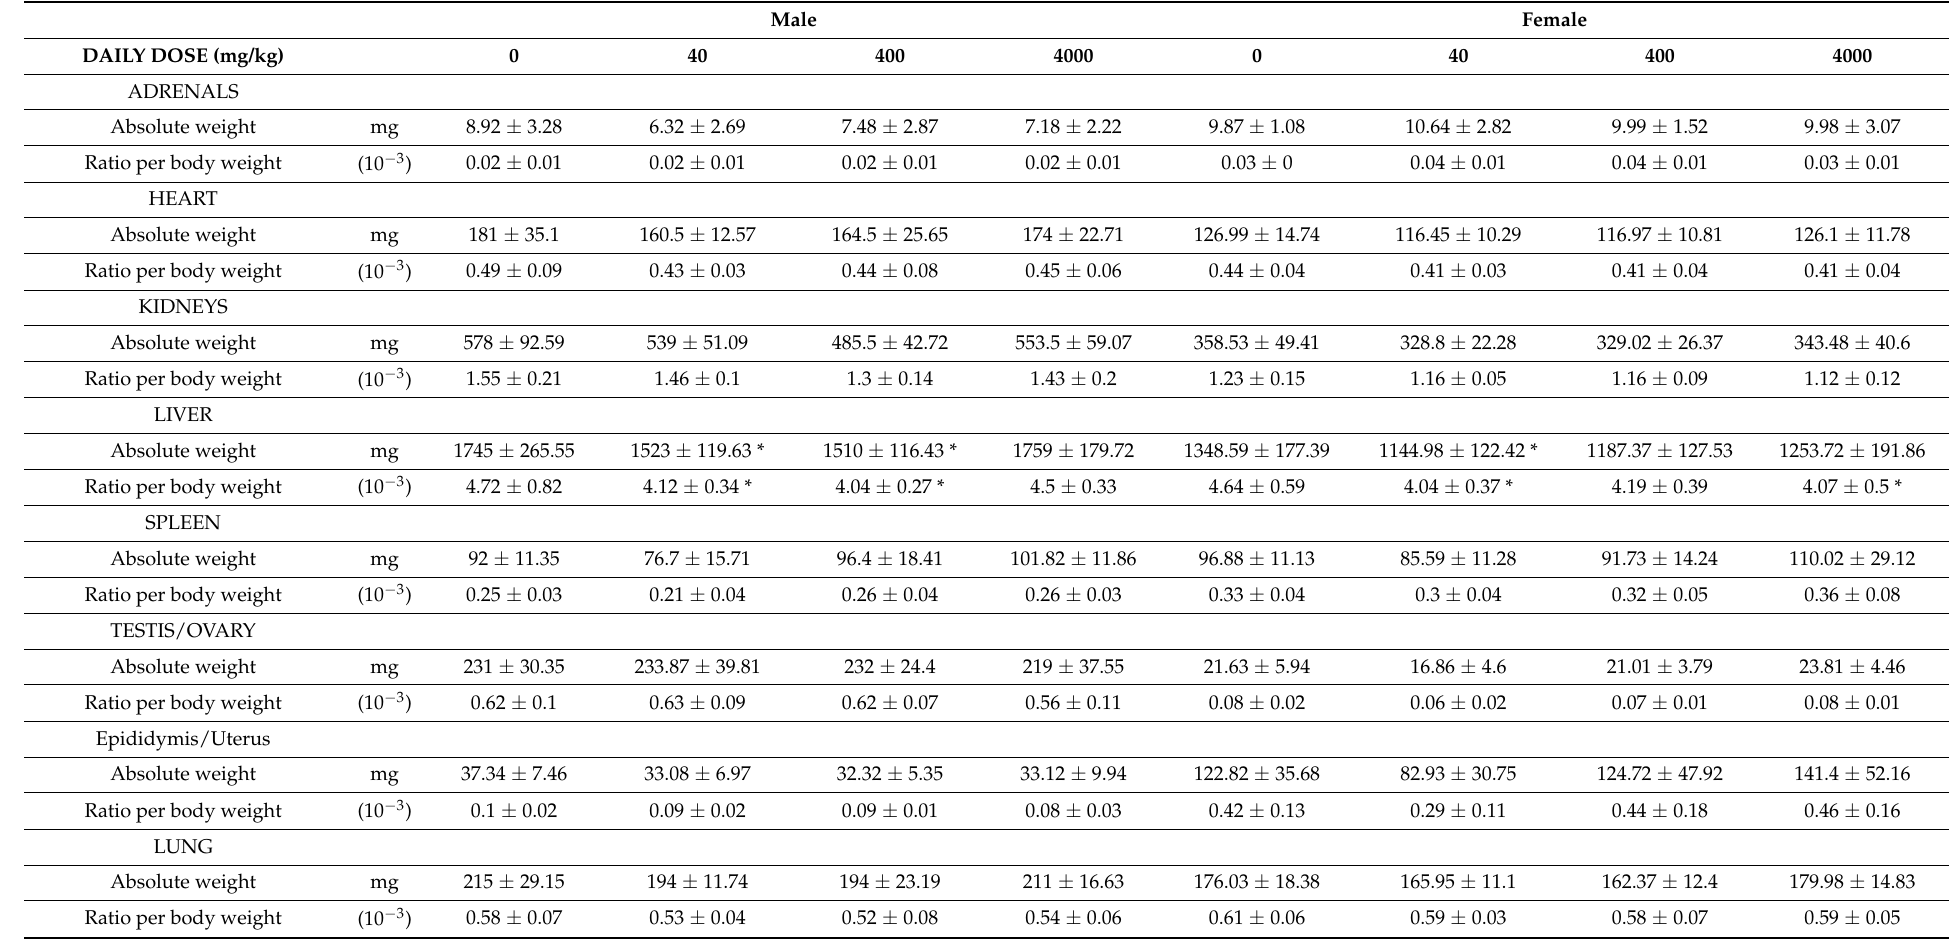
Table 7. Organ weight changes in male and female ICR mice after oral administration of L. paracasei PS23 powder. Male